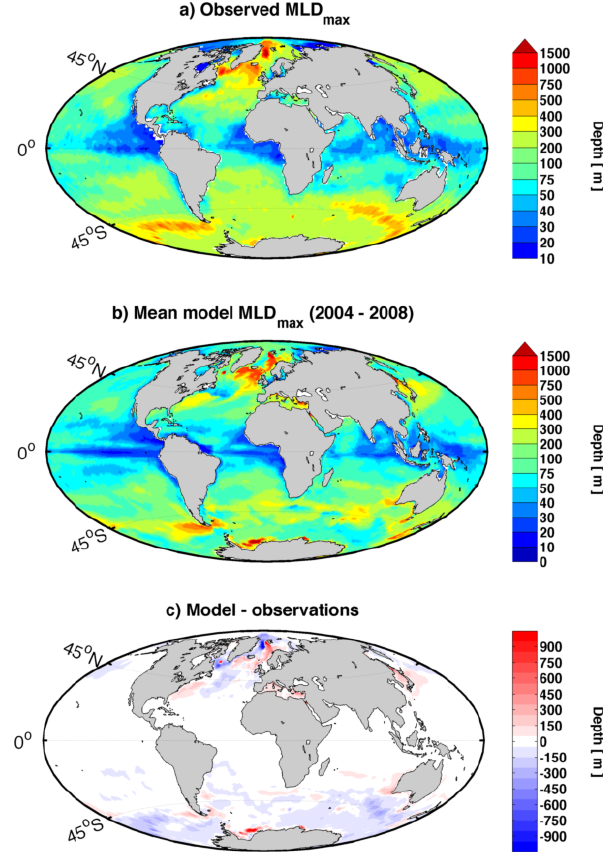
Figure 5. Mean spatial distribution of the MLD max over the years 2004–2008. (a) Observation based (de Boyer Montegut et al., 2004). (b) Modelled. (c) Residual: modelled − observation